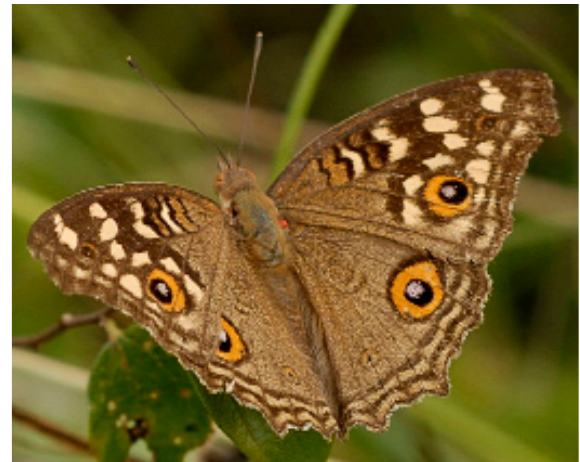
Image 17. Lemon Pansy Junonia hierta